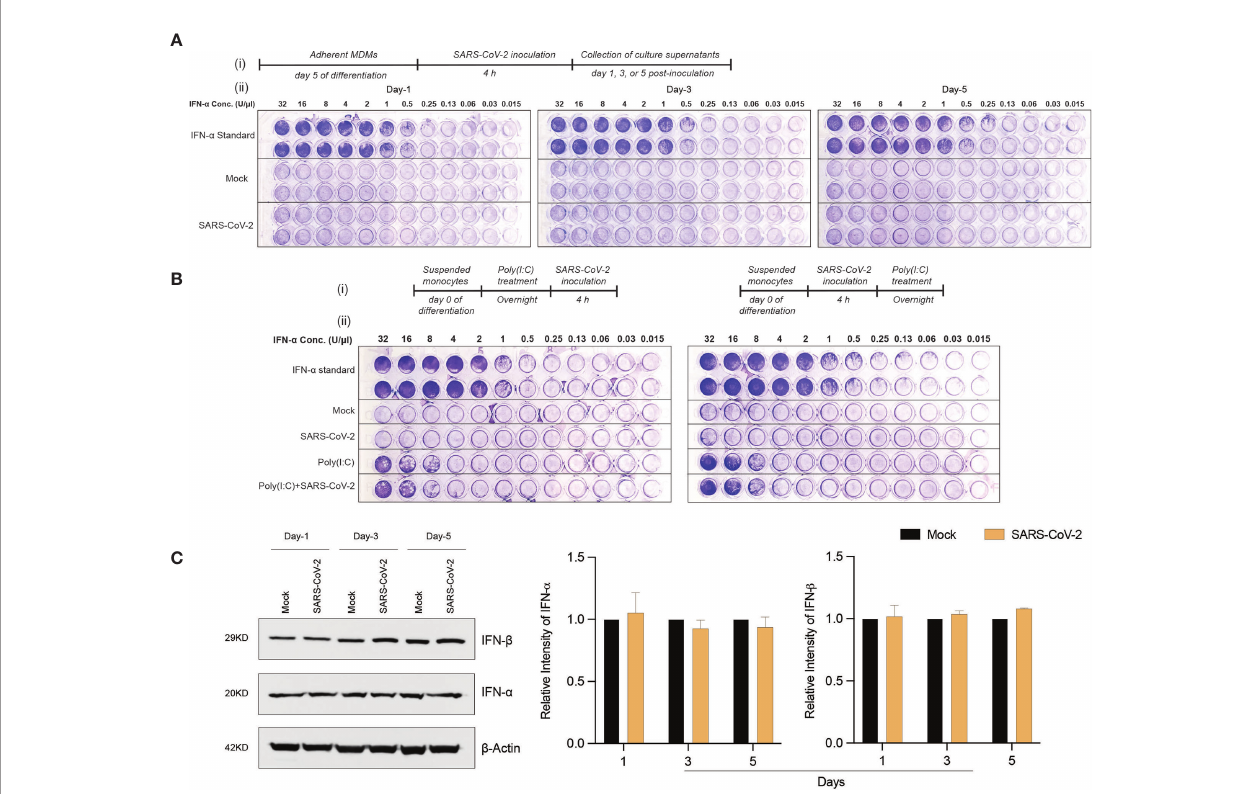
FIGURE 3 | SARS-CoV-2 does not induce IFN activity in monocytes-macrophages. (A) MDMs were infected with SARS-CoV-2 (MOI=0.01) and the culture supernatants were collected at days 1, 3, and 5 post-infection. The collected culture supernatants were used to assess IFN activity in VSV-challenged bovine MDBK cells. Recombinant human IFN- a was used as standard (64 U/ m l). 2-fold dilution was used for different conditions. ( A. i) Experimental timeline. ( A. ii) Representative images of IFN activity assay plates. (B) No additive or synergistic responses in poly(I:C)-induced IFN activity between control and SARS-CoV-2-challenged monocytes. Suspended monocytes were treated with 100 m g/ml poly(I:C) overnight before or after the infection with SARS-CoV-2 (MOI=0.01) for 4 h. ( B. i) Experimental timeline. (B .ii ) Representative images of IFN activity assay plates. (C) Western blot analysis was performed to determine expression of IFN- a and IFN- b in cell lysates at different times after viral exposure. Representative immunoblot and densitometric quanti fi cation are shown. All experiments were done at least twice, and one representative image is shown. (C) Data represent mean ± SEM (n=3 donors). Statistical signi fi cance between the groups was determined with unpaired Student ’ s t-test and p < 0.05 was considered signi fi